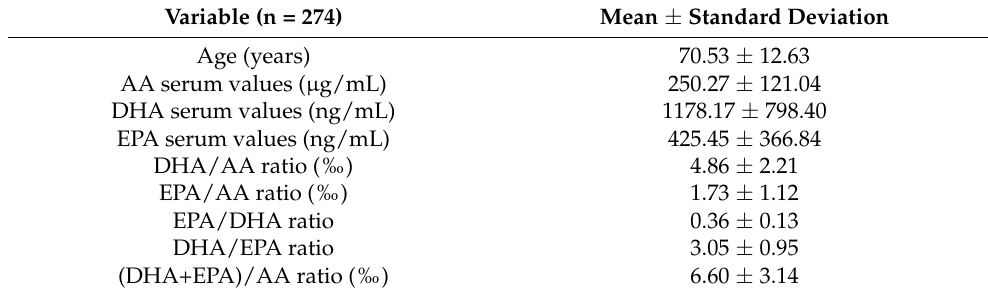
Table 1. Descriptive